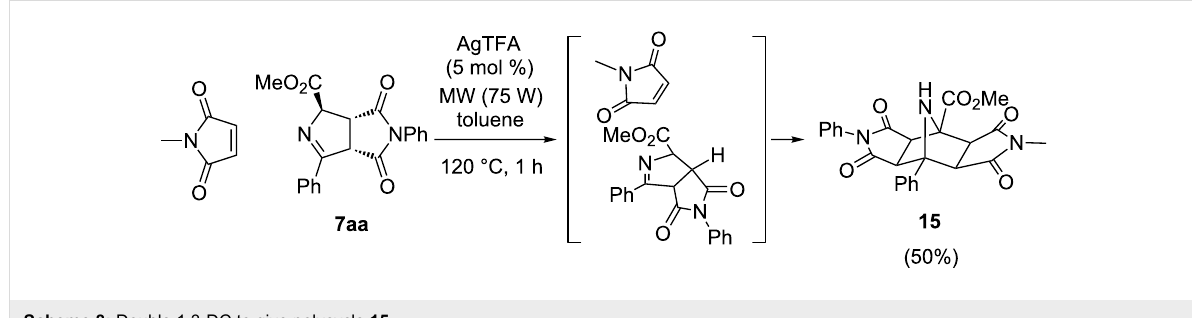
Scheme 8: Double 1,3-DC to give polycycle 15